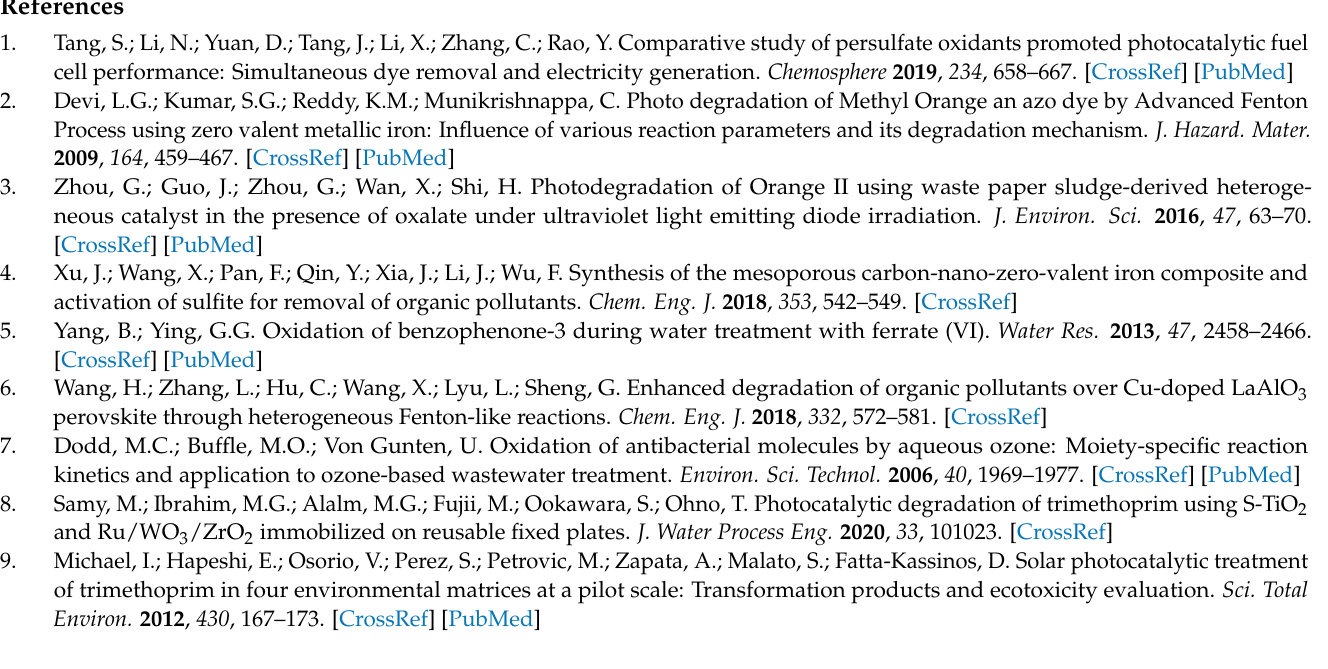
Figure S3: XPS spectra of Fe 2p for the MAER catalyst. Figure S4: The SEM image of Fe 3 O 4 . Figure S5: (a) N 2 adsorption/desorption isotherm of MAER; (b) The BJH (Barrett, Joyner and Halenda) pore size distribution of MAER. Figure S6: Adsorption behavior of X-3B on three synthesized materials. Figure S7: Zeta potentials of Fe 3 O 4 and MAER in different solution pH values. Figure S8: Matrix effects of (a) Cl − , b) NO 3 − , (c) SO 42 − , and (d) HA on X-3B removal in a MAER UV–Fenton system. Reaction conditions: C 0, X-3B = 50mg/L, [Material] = 0.25 g/L, [H 2 O 2 ] = 150 mM, T = 25 ◦ C, and pH with no adjustment. Figure S9: SEM images of MAER (a) before and (b) after a UV–Fenton reaction. Figure S10: (a) X-3B sample and (b) actual wastewater sample collected at different reaction times, X-3B sample (c) before and (d) after a UV–Fenton reaction, and an actual wastewater sample (e) before and (f) after a UV–Fenton reaction. Table S1: Properties of the selected dye. Table S2: Properties of an actual textile dyeing wastewater sample. Table S3: Surface structural properties of